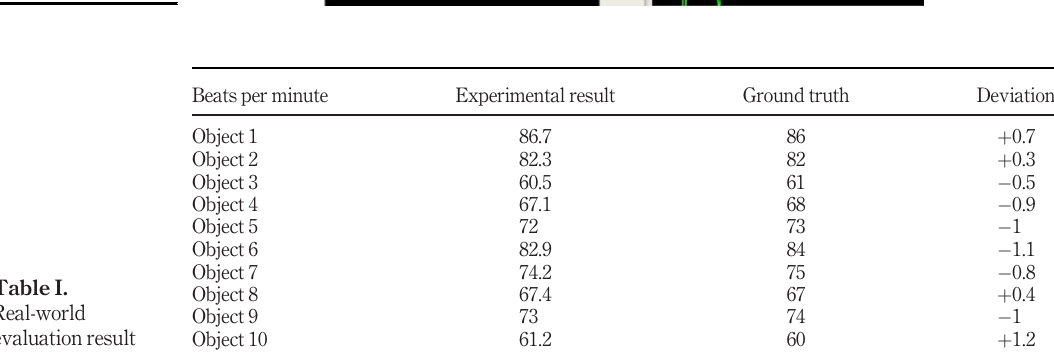
Figure 6. A screenshot of the real-time heartbeat curve